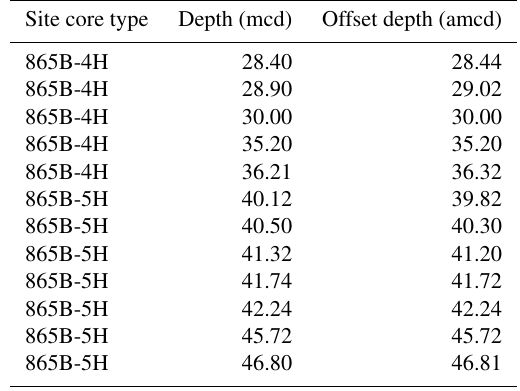
Table 4. Mapping pairs for adjusting mcd to amcd for ODP Hole